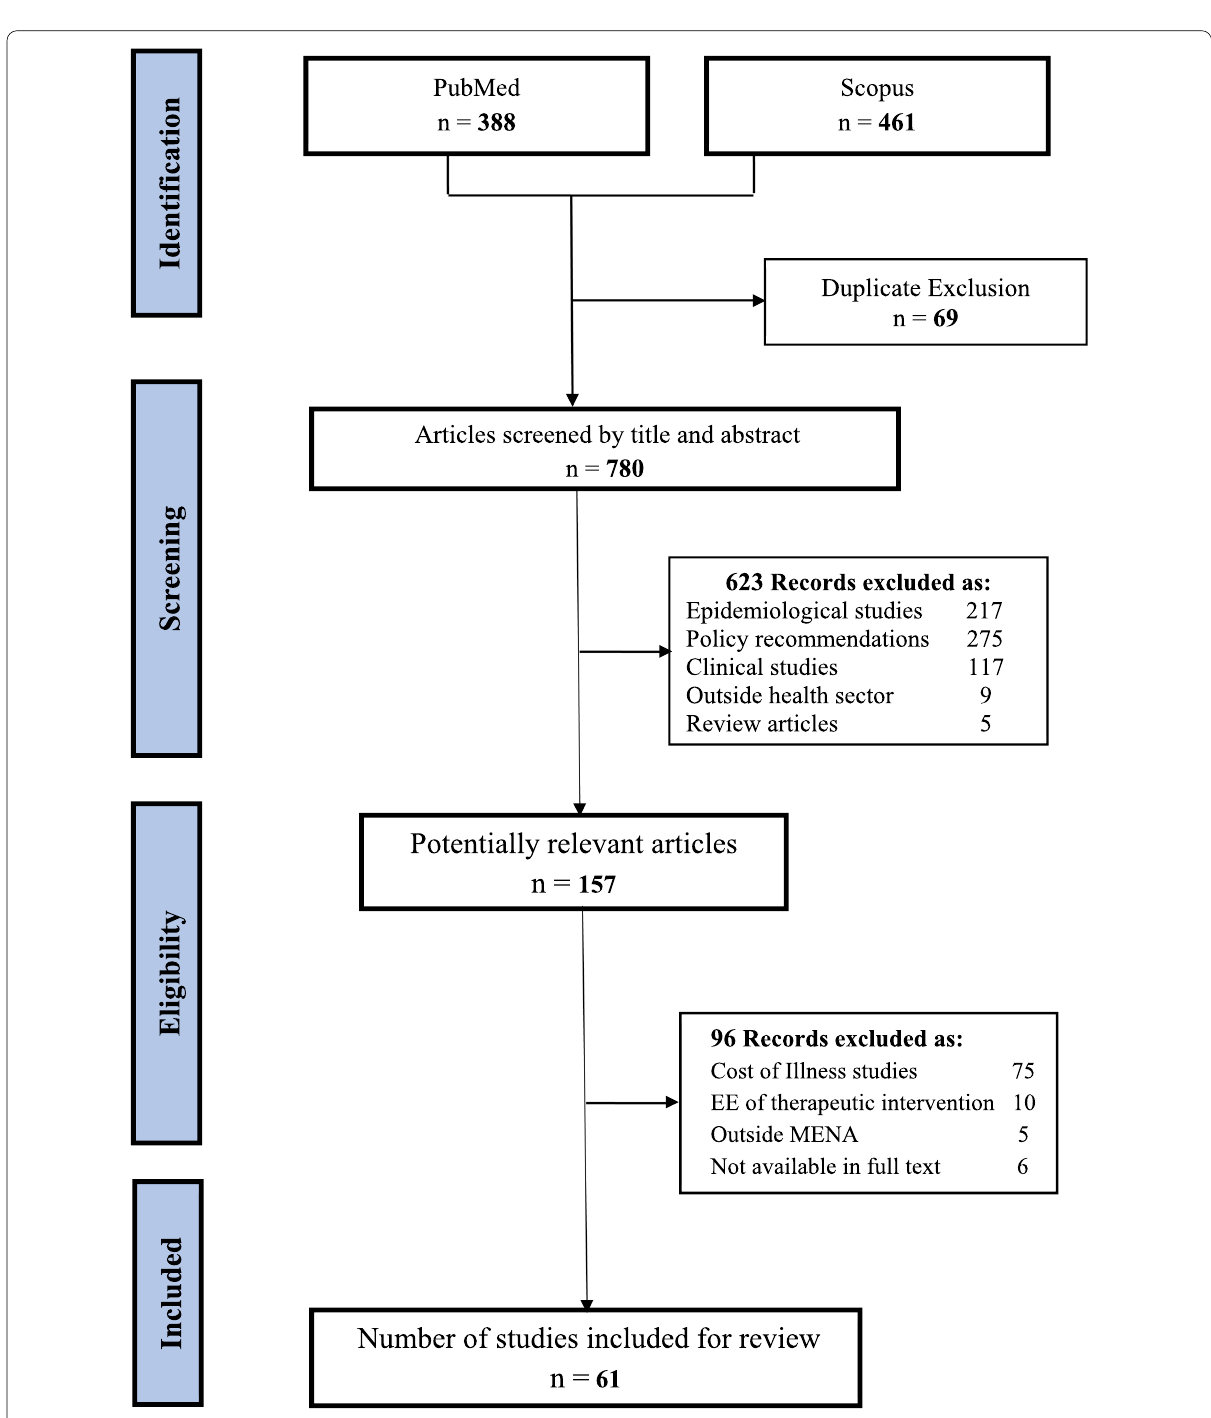
Fig. 1 PRISMA flow chart of search